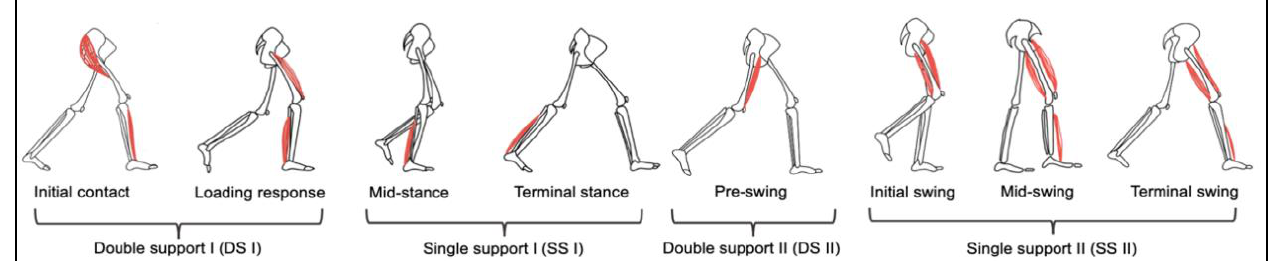
Figure 1. Illustration of a complete gait cycle with the right leg’s events, separating the eight gait phases: Initial contact, loading response, mid-stance, terminal stance, pre-swing, initial swing, mid-swing, and terminal swing.